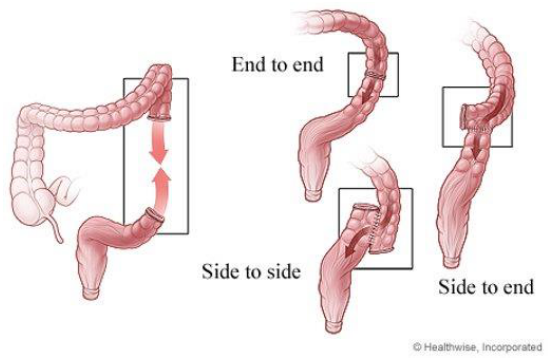
Figure 1. Types of anastomosis (with permission from © Healthwise, Incorporated.